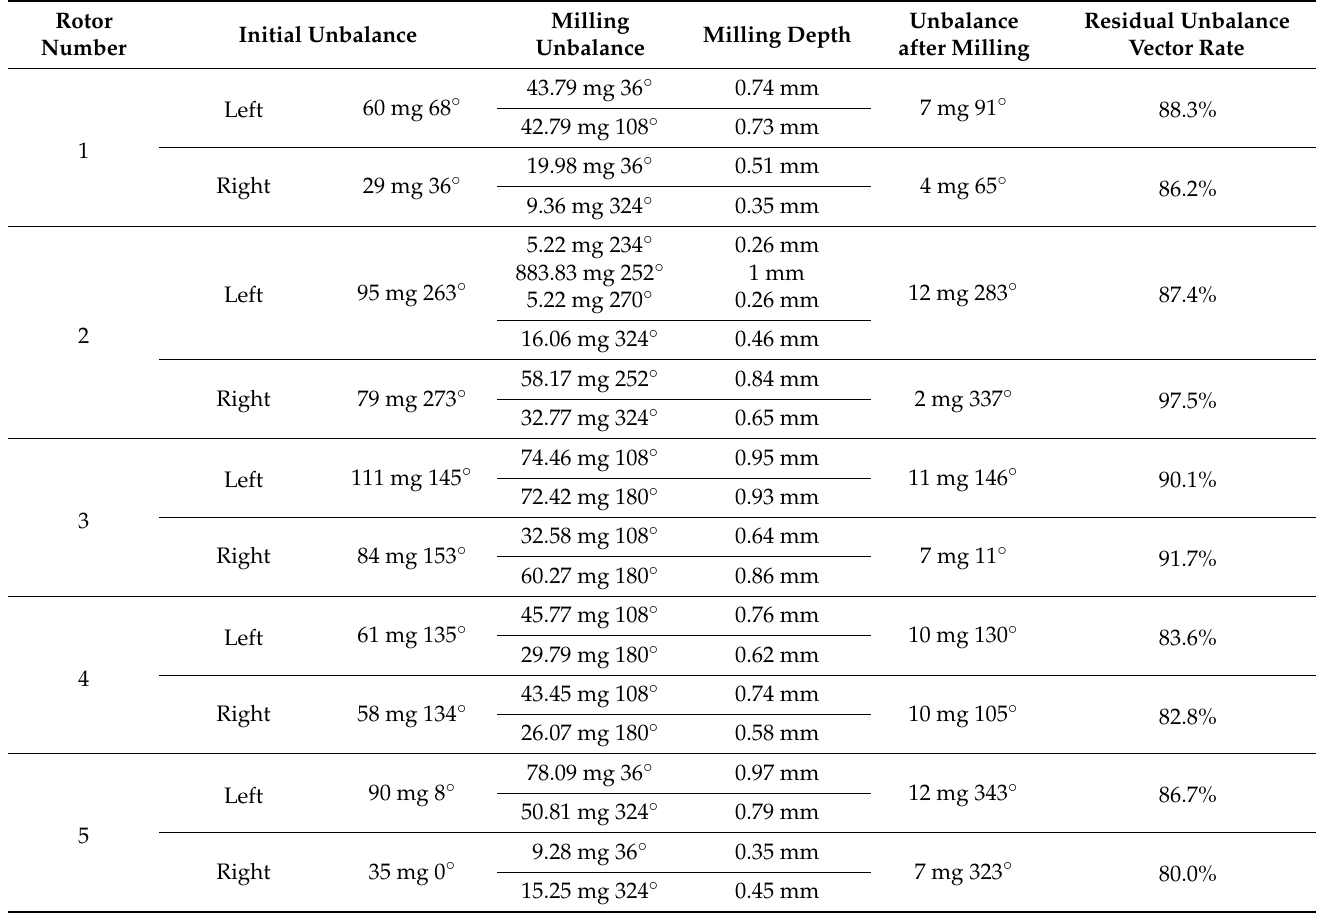
Table 3. Residual unbalance vector rate of the rotor under the discrete